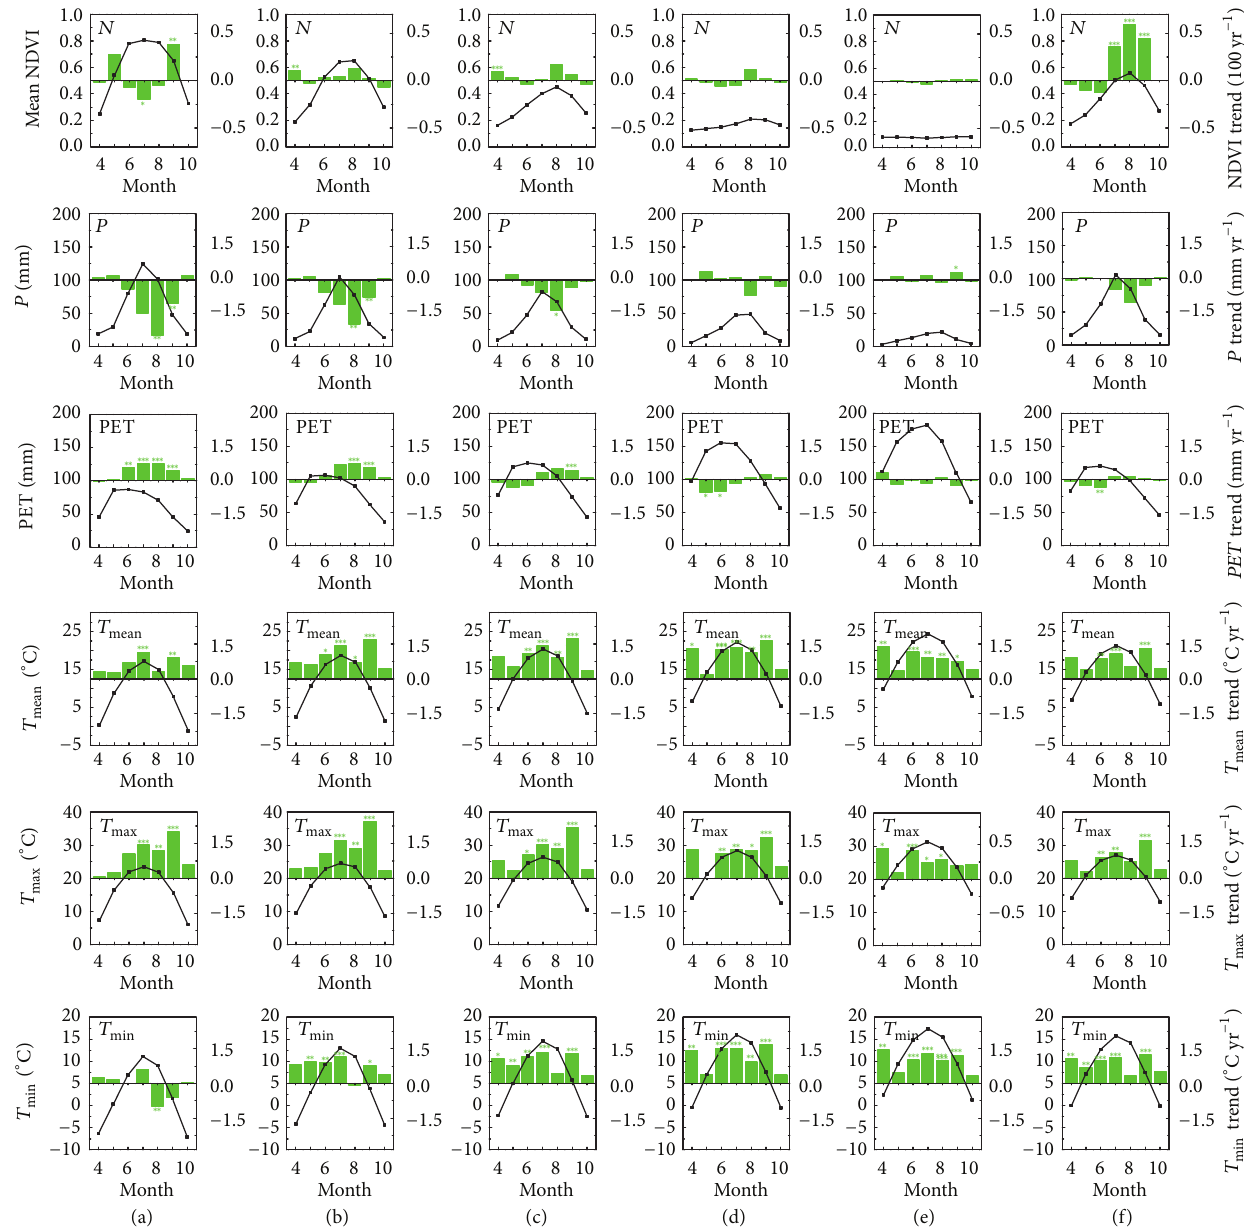
Figure 3: Variation in monthly NDVI and climatic variables during growing season over the 25 years for the six vegetation types: (a) forest, (b), meadow steppe, (c) typical steppe, (d), desert steppe, (e) desert, and (f) cropland. Monthly 𝑃 , monthly PET, and monthly 𝑇 𝑇 min . The green bars denote the trends, and black lines represent the mean values.